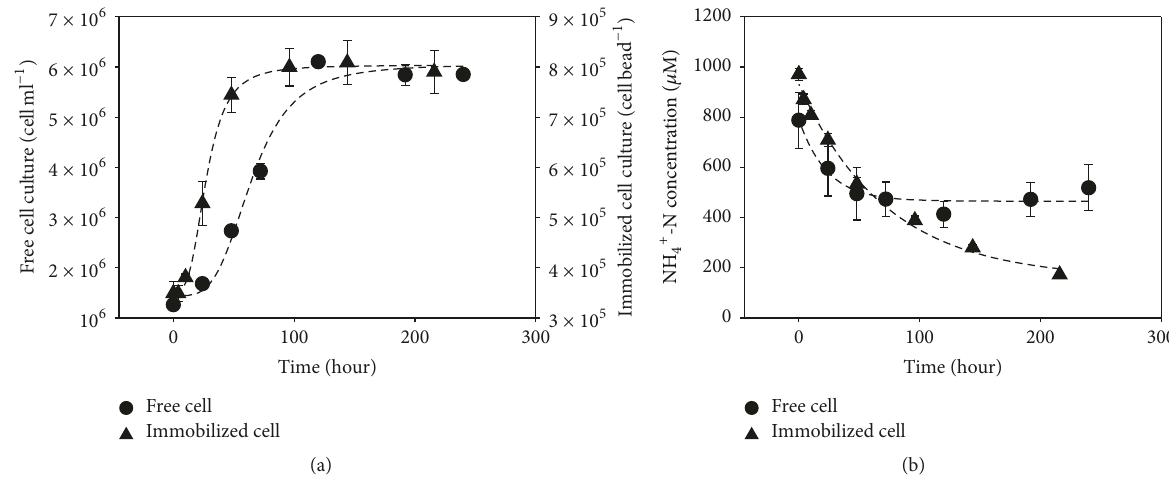
Figure 4: (a) Growth and (b) NH 4+ -N uptake of free and immobilized cell incubated in f/2 medium enriched with 900 𝜇 M NH 4+ -N. Markers are mean and vertical bars showed standard deviation with 𝑛 = 3 . Table 1: Summary of the results and 𝑡 -test of free and immobilized cell incu bated in f/2 medium enriched with 900 𝜇 M NH 4+ -N. 𝑛 = 3 . Free cell Immobilized cell Parameter